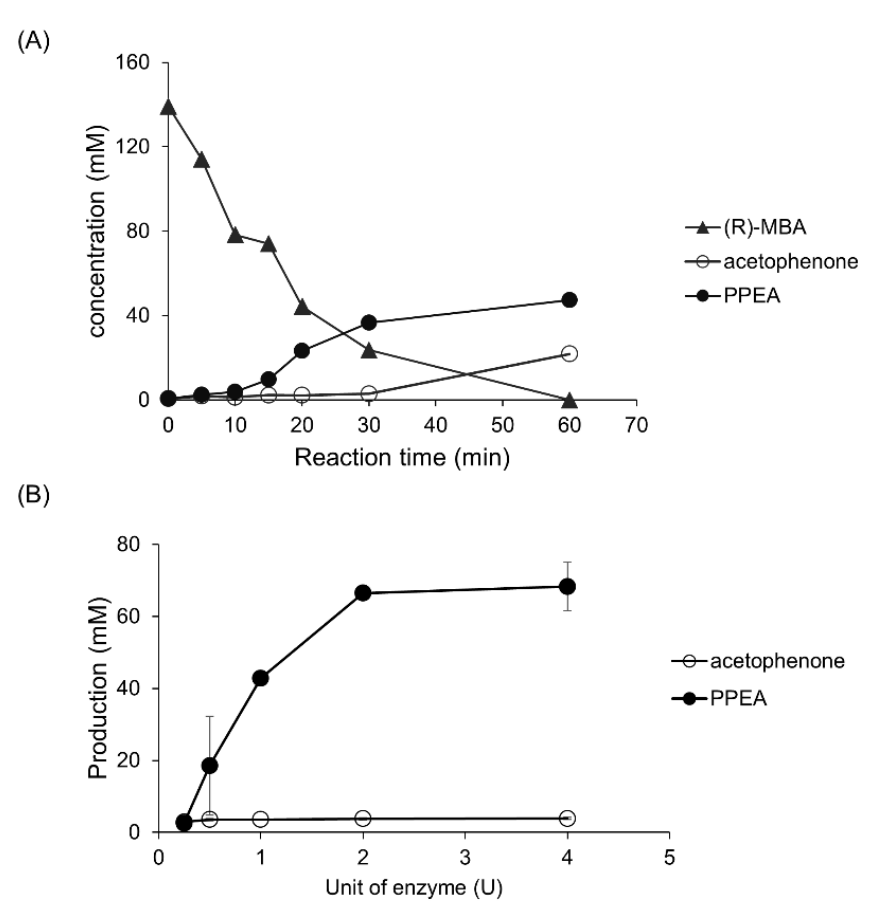
Figure 2. Time course of the production of PPEA ( • ) and acetophenone ( ) from ( R )–MBA with (cid:35) variant pkDAO. ( A ) The reaction was performed at 20 ◦ C using 150 mM ( R )-MBA pH 9.0 and 2 U of variant pkDAO in various incubation times. ( B ) The reaction was performed at 20 ◦ C for 60 min using 150 mM ( R )-MBA of pH 9.0 and 0.5–4 U of variant pkDAO. The amounts of imine and acetophenone were measured using gas chromatography–mass spectrometry